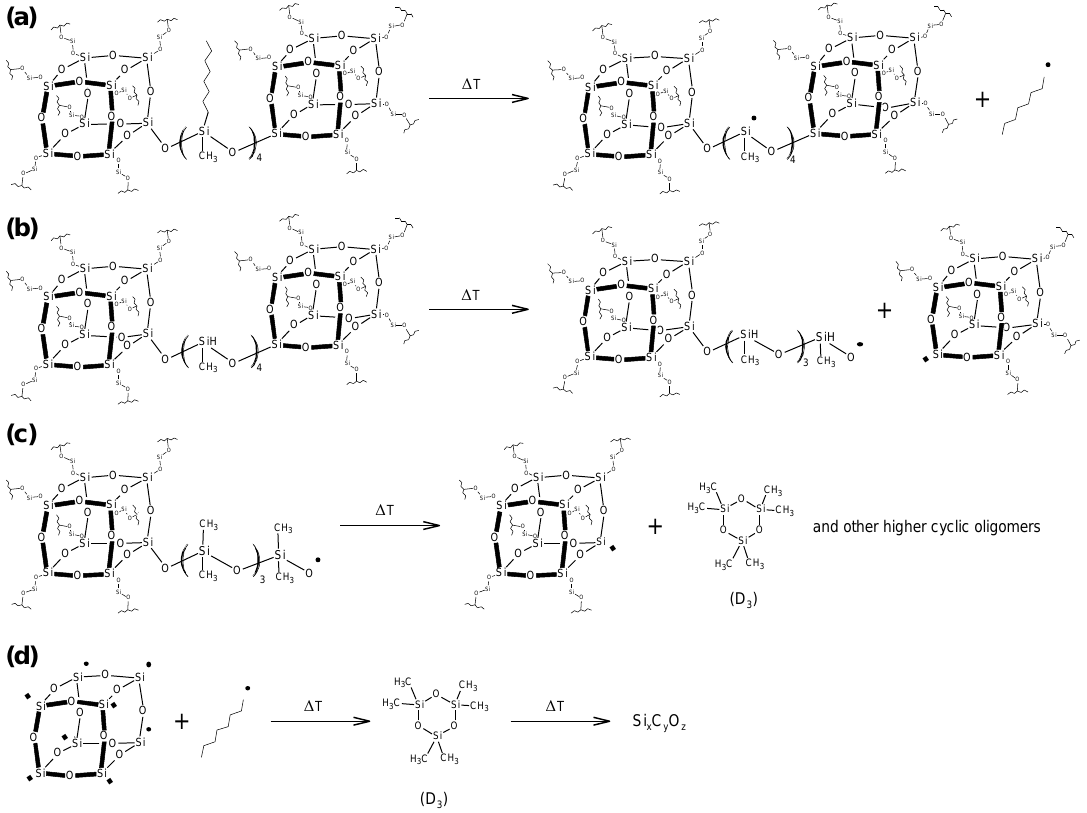
and other higher cyclic